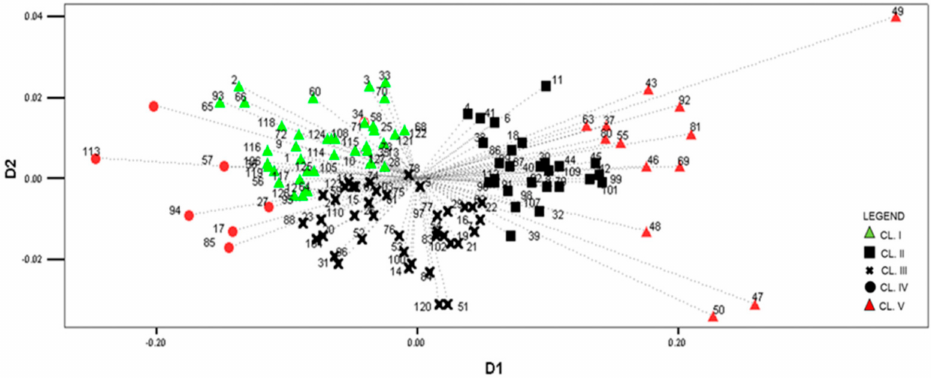
Figure 4. Distribution of MRIZPGB yellow-orange landraces according to the correspondence analysis. Table 6. Eigenvalues and % of variance for discriminant functions. Function 1 Eigenvalue % of Variance Cumulative %